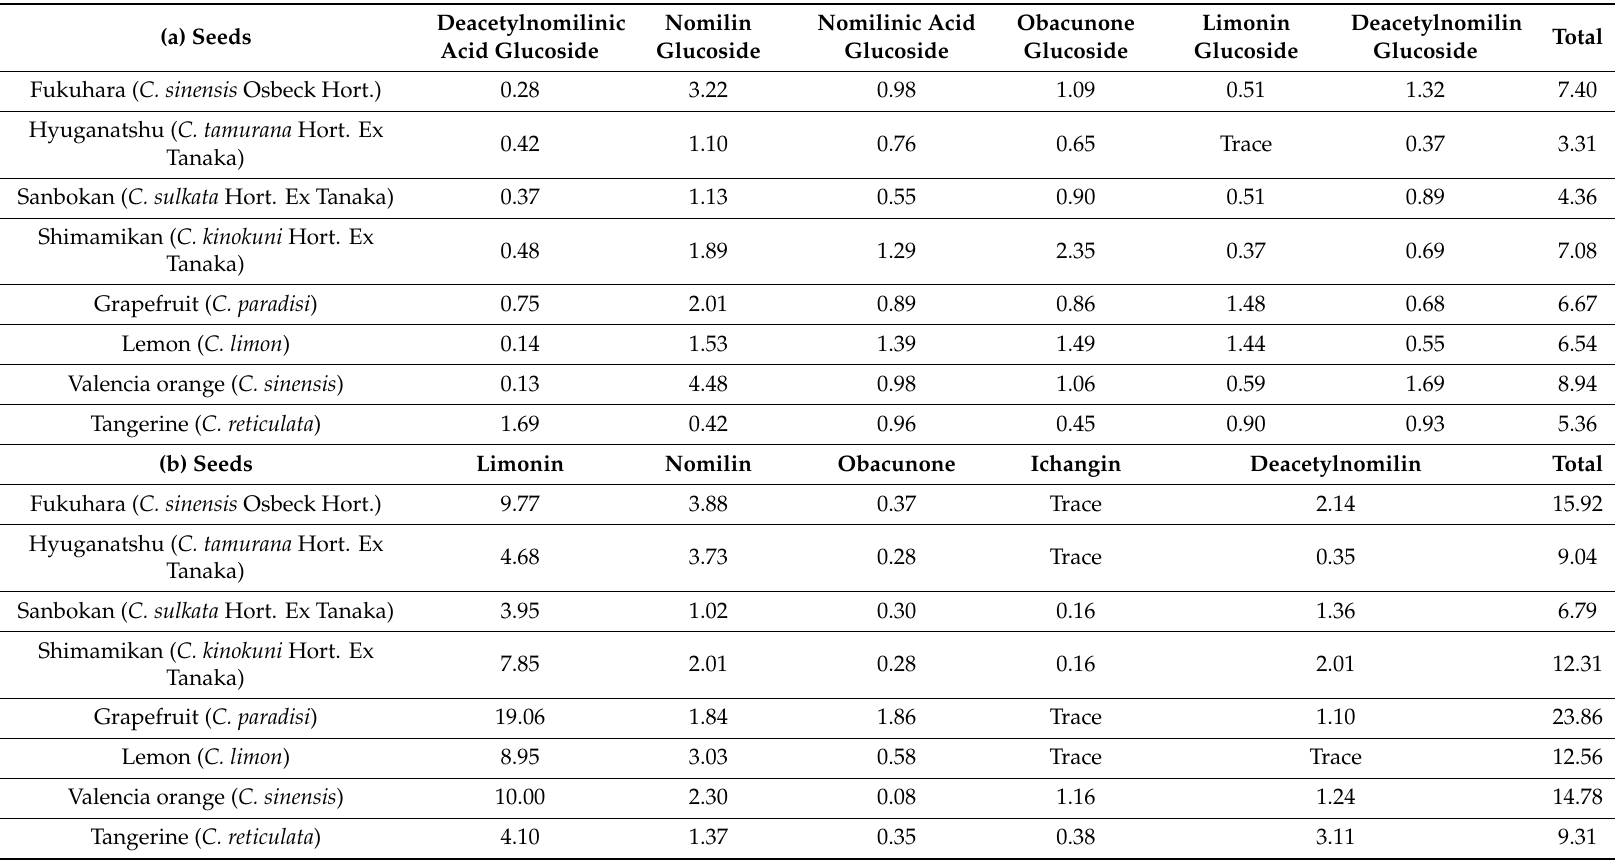
Table 6. ( a ) Limonoid glucosides in various citrus fruit seeds extracted in hexane and estimated from reverse-phase HPLC; ( b ): composition of limonoid aglycons in various citrus fruit seeds [101]; (values are expressed in mg / g of dry